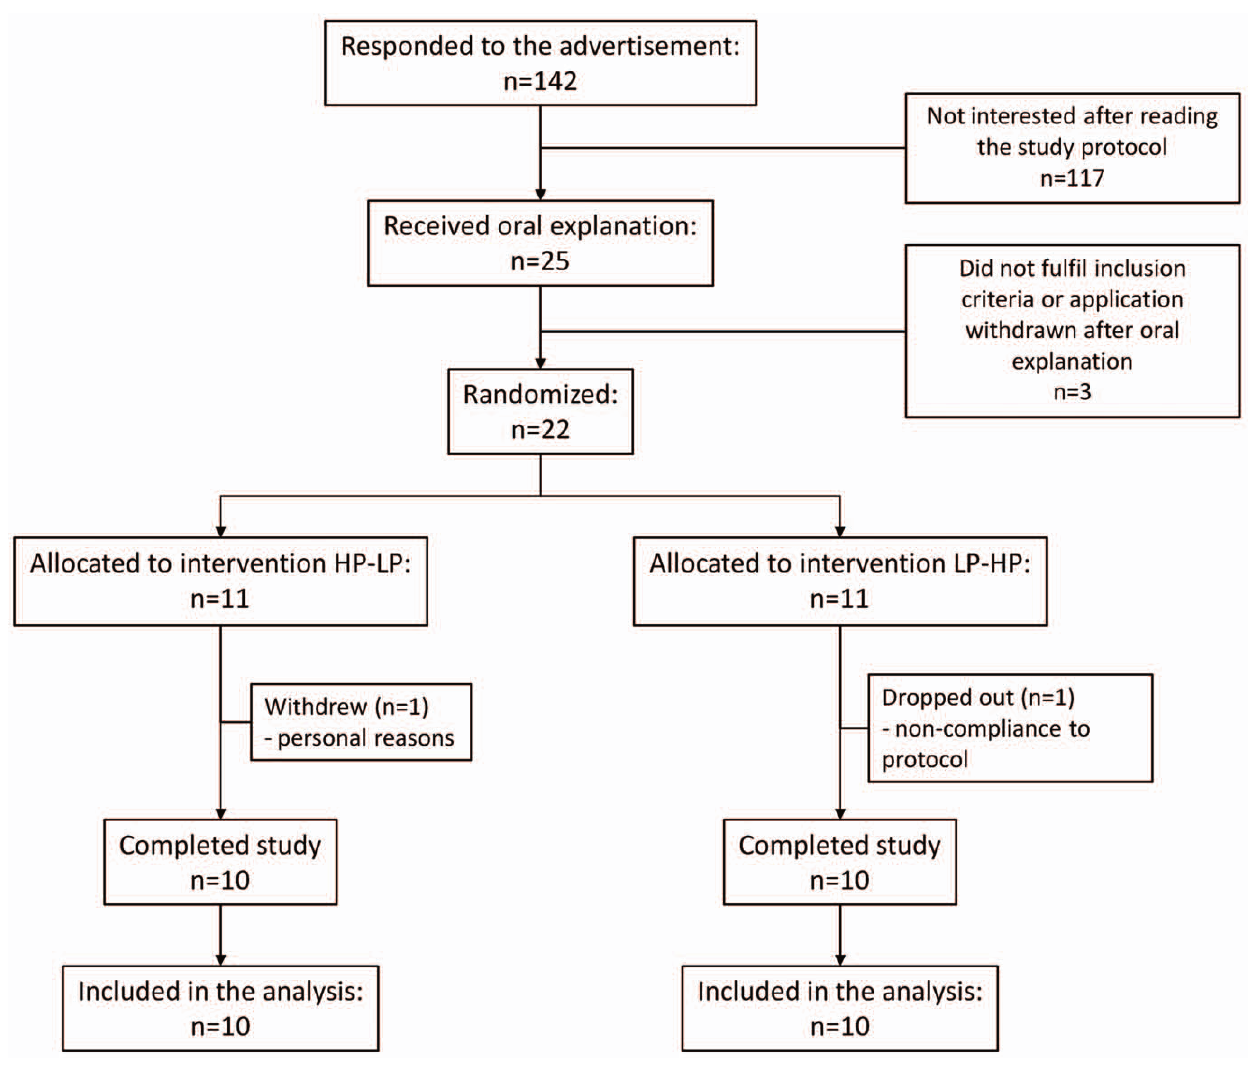
Figure 1. Enrollment of the volunteers.